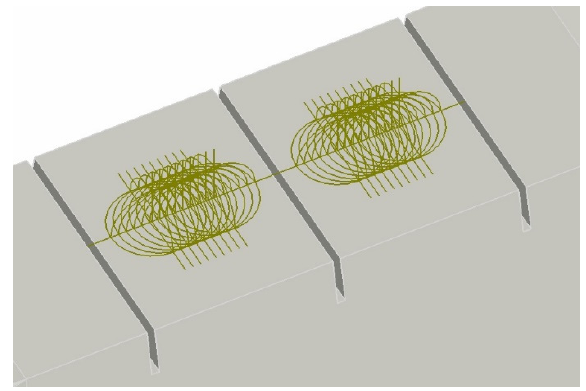
Figure 19. Stress monitoring points in the numerical model.